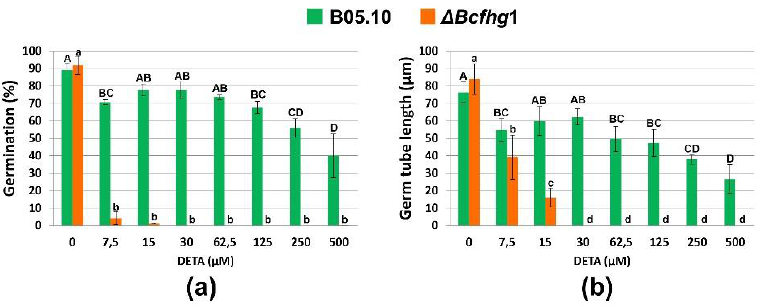
Figure 3. Effects of DETA on germination ( a ) and germ tube growth ( b ) in B. cinerea strains B05.10 and ∆ Bcfhg 1. Percentage of germinated spores (stage 1 + stage 2) and germ tube length were determined after 4 and 10 h of incubation, respectively, under the different concentrations of the NO donor indicated. Values are the means of three replicates ± SD ( n > 100 each). Differences between concentrations for each strain were tested by one-way ANOVA followed by the Bonferroni test at p < 0.05. Uppercase letters represent groups of the B05.10 strain. Lowercase letters represent groups of the Δ Bcfhg 1 strain.